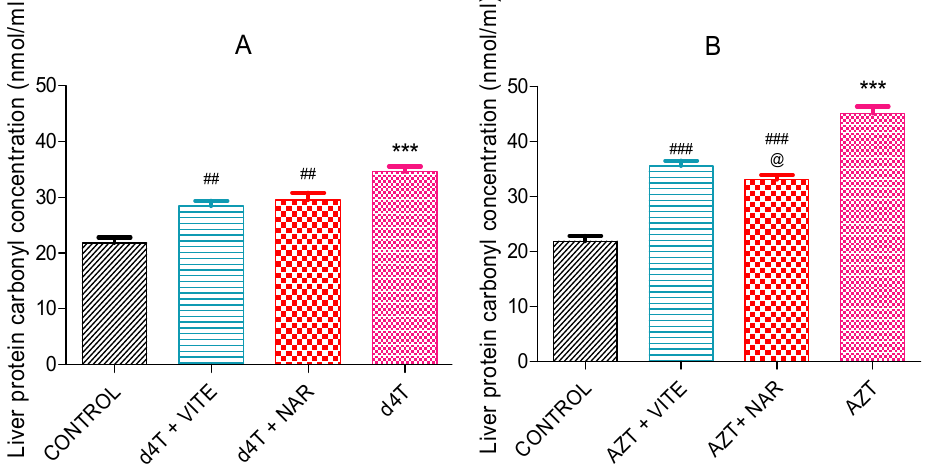
Figure 6. Concentrations of oxidized protein products in the liver after 56 days of drug administration. ( A ) d4T ‐ ((*** p < 0.001 compared to control; ## p < 0.01 compared to d4T and ( B ) AZT ‐ (*** p < 0.001 compared to control; ### p < 0.001 compared to AZT) treated animals. @ p < 0.05 compared to vitamin E among AZT ‐ treated rats.